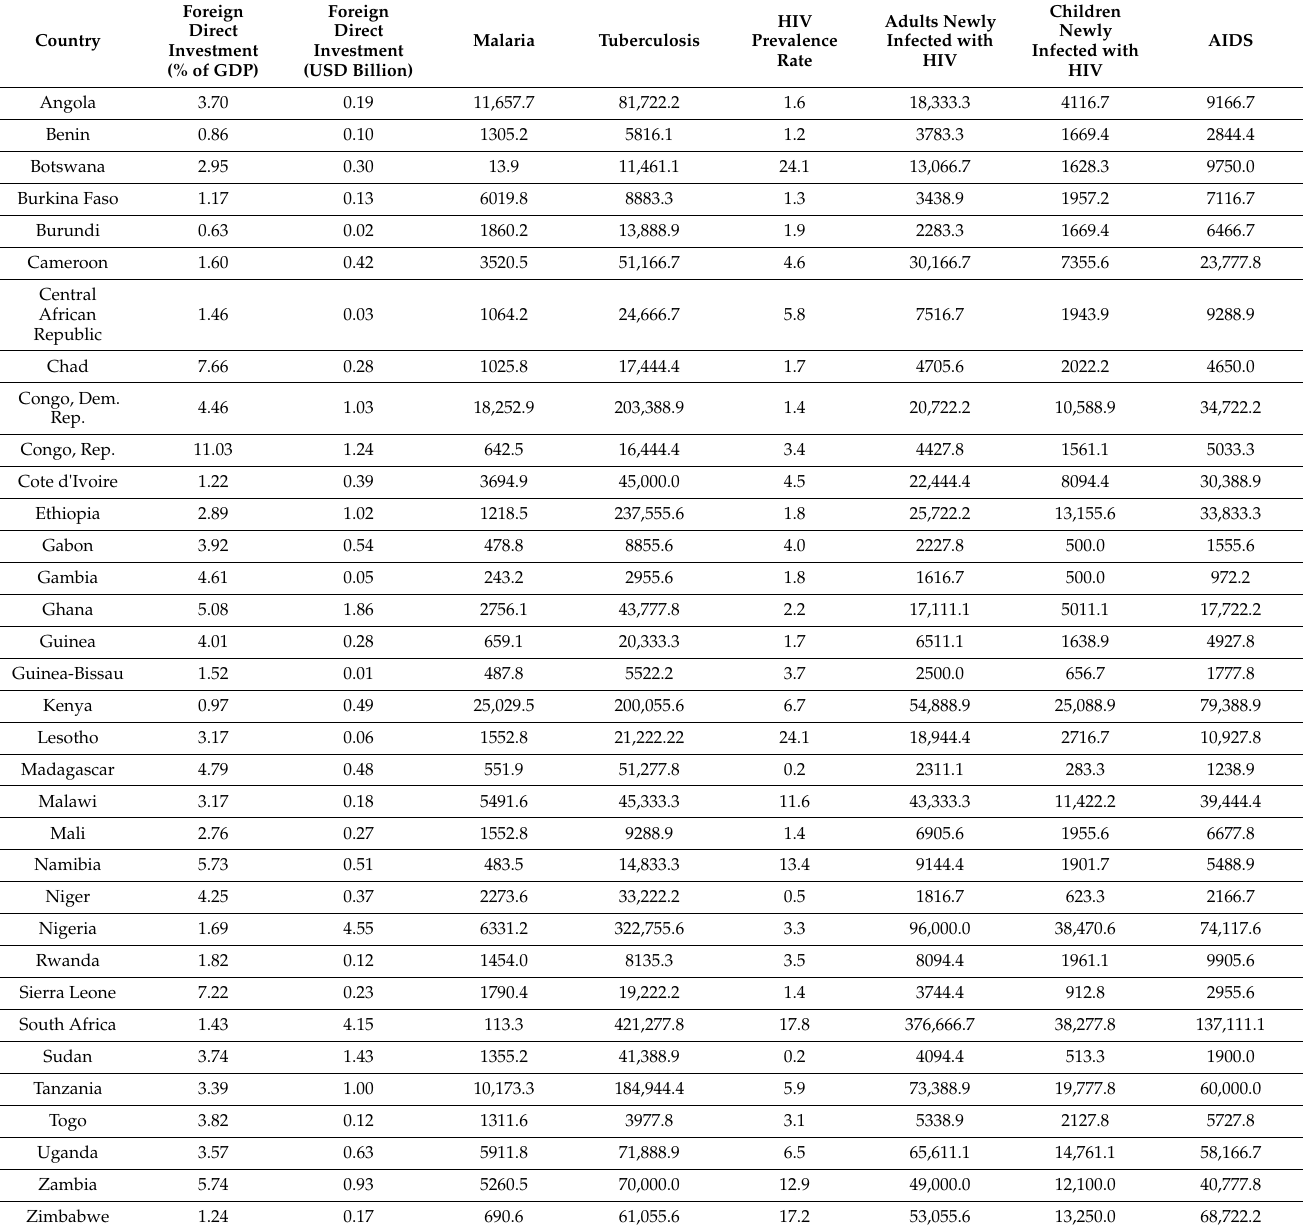
Table 1. Annual averages of infectious diseases and FDI of countries within the SSA